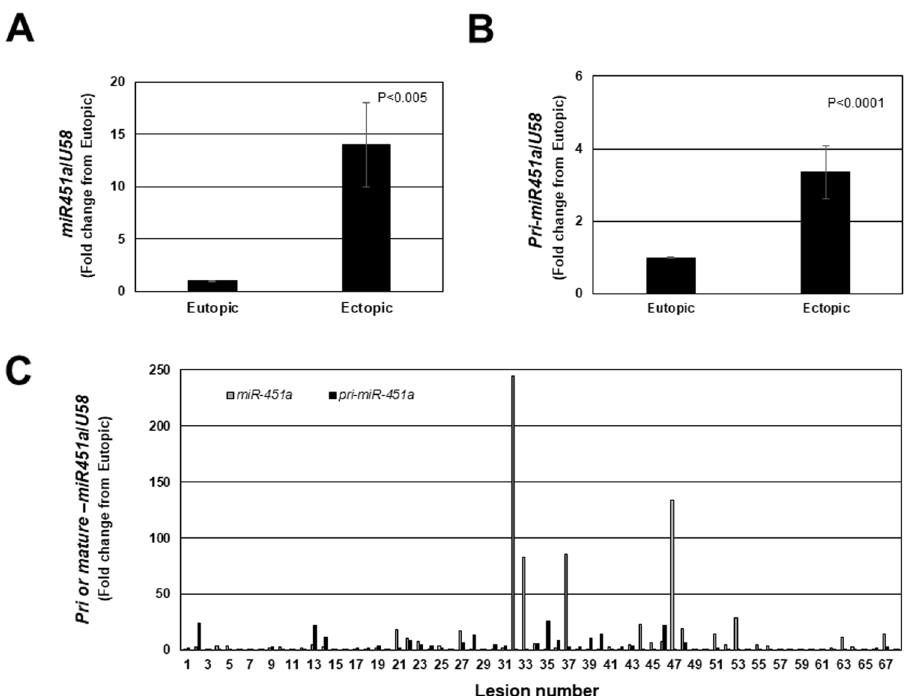
Figure 3. Mature miR-451a and pri- miR-451a average and individual lesion expression in human endometriotic lesion tissue. Matched endometriotic lesion and corresponding eutopic endometrial tissue was processed for RNA isolation and miR-451a ( A ) and pri-miR-451a ( B ) expression was determined by qRT-PCR as described under “Materials and Methods”. All data are displayed as the mean ± the standard error of the mean (SEM) and p-values are indicated for each assessment for eutopic endometrial samples. ( C ) Ratio (fold change from eutopic tissue expression) of mature miR-451a and pri- miR-451a in each individual lesion (N = 68). Data did not pass normality testing and were therefore analyzed using the non-parametric Mann-Whitney